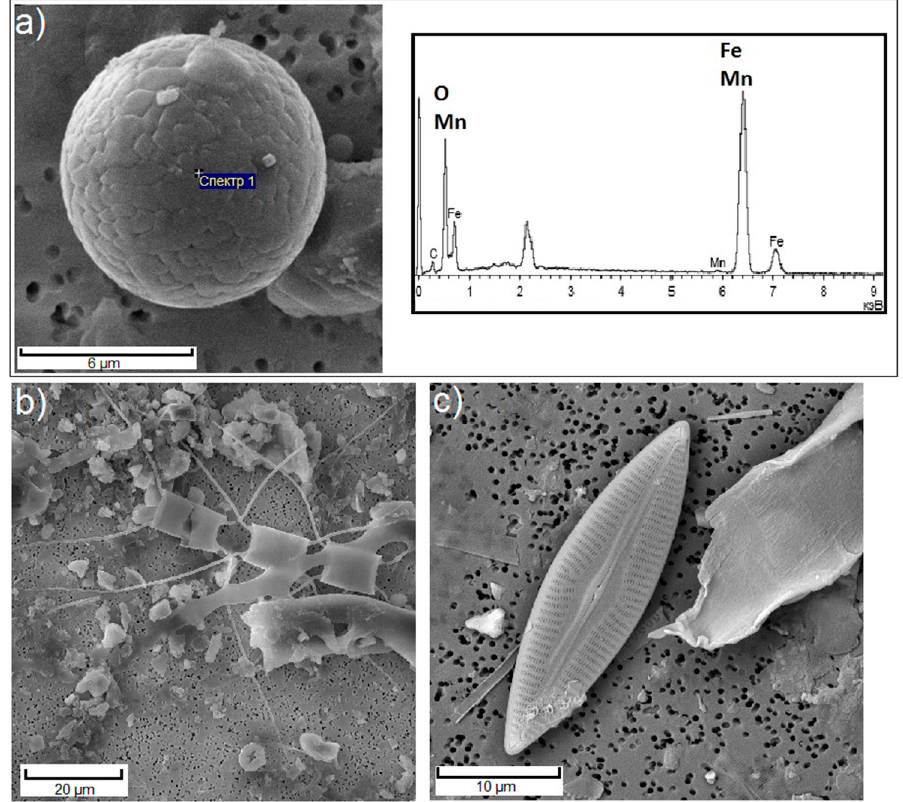
Figure 4. The composition of the SPM in snow (data from a scanning electron microscope): ( a ) Slag and its composition obtained using the attachment, a microanalyzer to a scanning electron microscope, ( b ) diatomic and mineral particles; ( c ) diatoms and organic tissue (Port Ekonomiya).